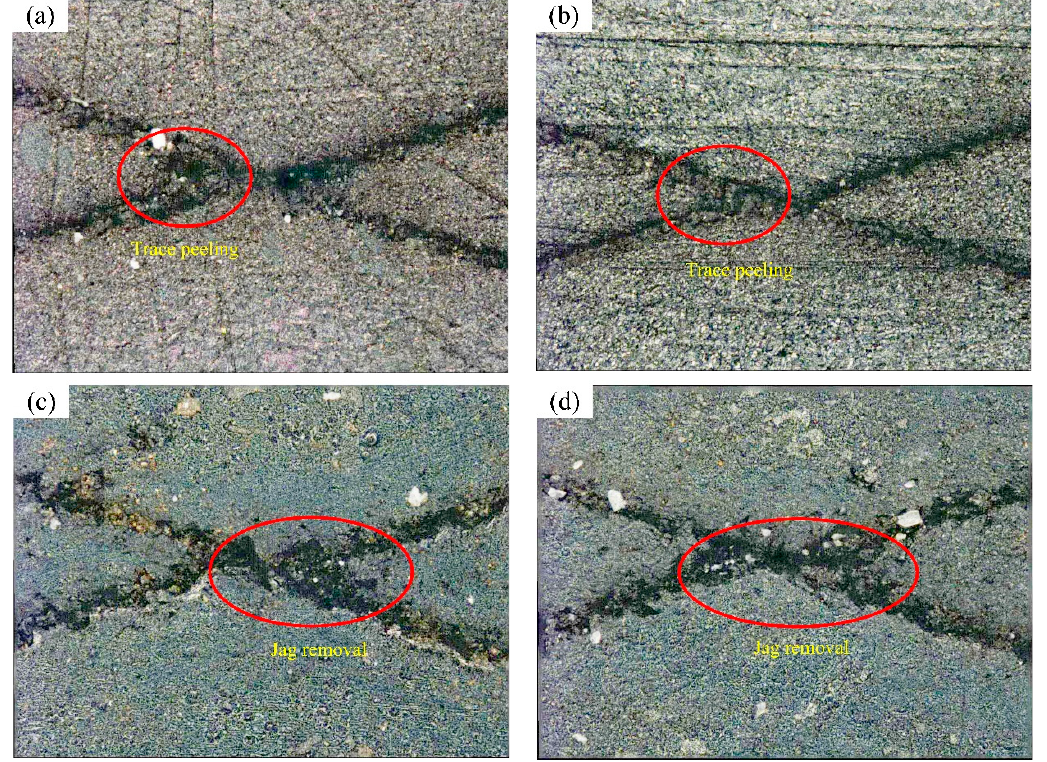
Figure 7. Optical microscopy images of the ‘X’ mark on (Ti:N)-GLC films: ( a ) Ti-C (100); ( b ) TiC-C (100); ( c ) TiN-C (100); ( d ) GLC. Table 5. Film adhesion ratings according to ASTM D3359-97.